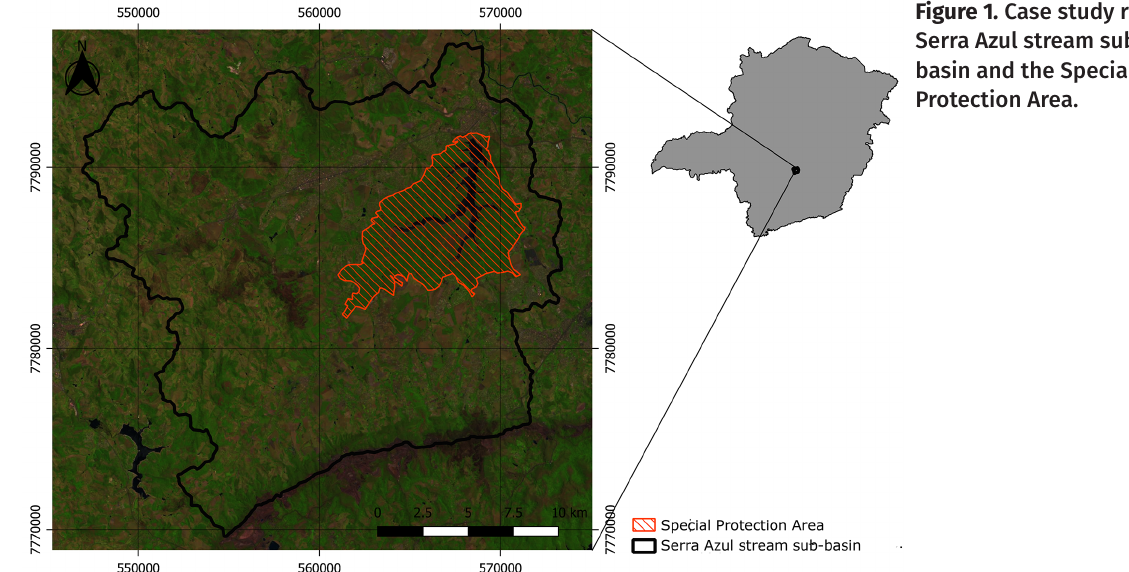
Figure 1 . Case study region: Serra Azul stream sub- basin and the Special Protection